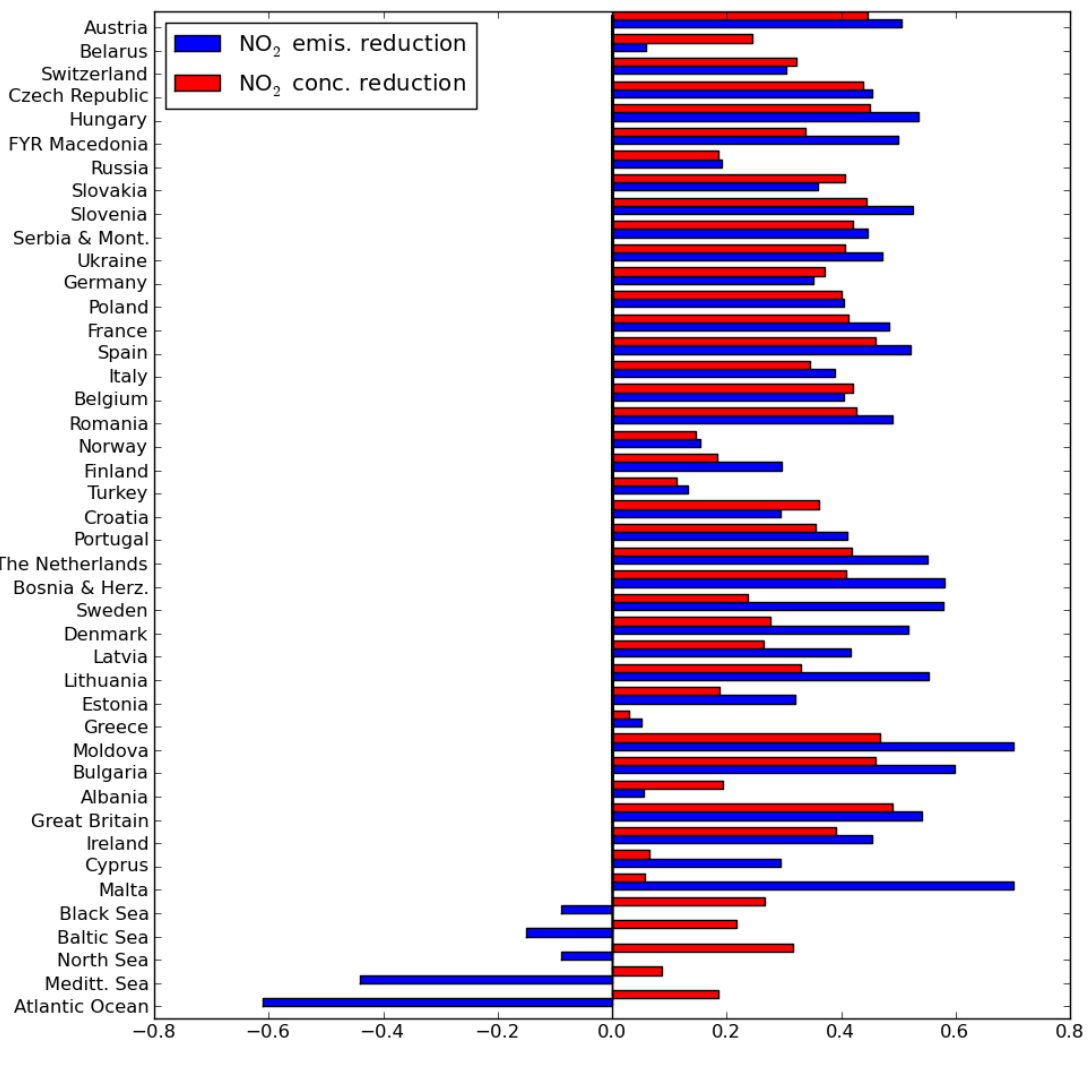
Figure 9. Comparison of expected relative emission change to the relative change in the OMI-NO column for all countries in Europe and surrounding seas. Countries are 2 ordered from continental landlocked countries to coastal countries. The last areas given represent sea